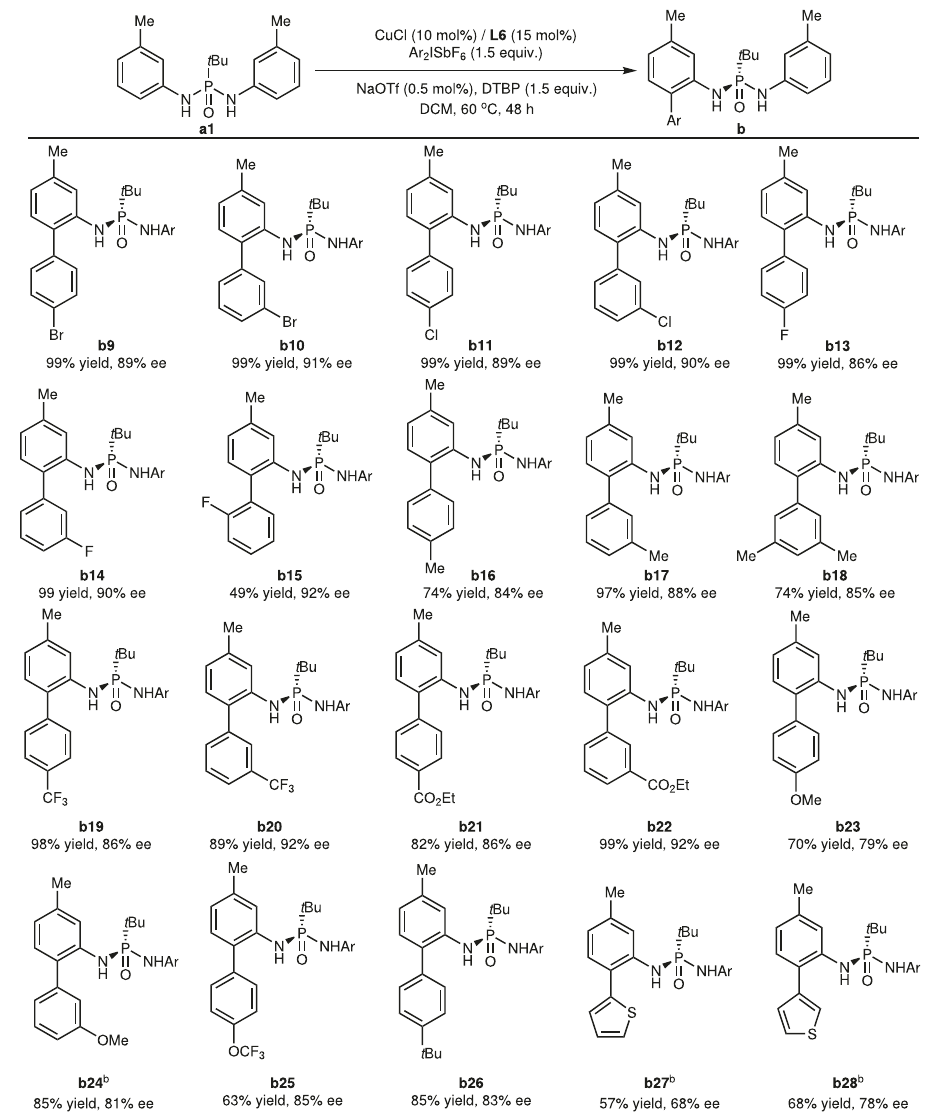
Fig. 3 | Substrate scope with diaryliodonium salts. Reaction conditions unless otherwise noted: a1 (0.10mmol), Ar 2 ISbF 6 (0.15mmol), CuCl (0.01mmol), L6 (0.015mmol), NaOTf (0.0005mmol), DTBP (0.15mmol), DCM (2mL) in a sealed tube at 60°C for 48h. b [ArIMes]SbF 6 was used. DTBP 2,6-di- tert